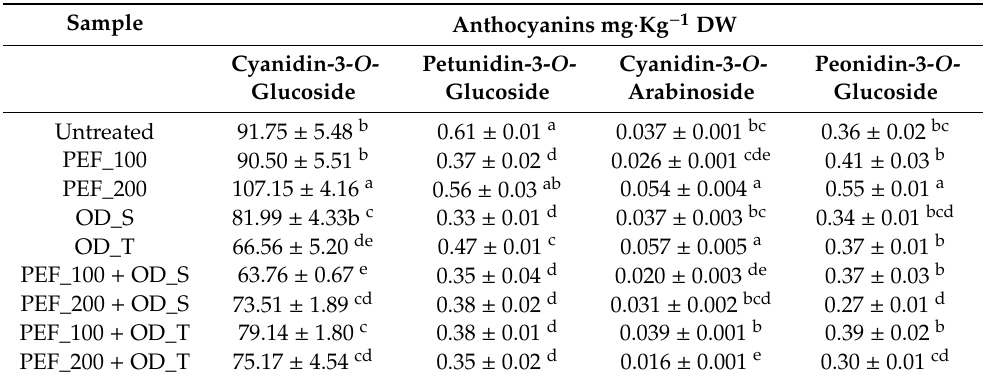
Table 2. Anthocyanins quantified in untreated and treated strawberry samples before in vitro digestion.